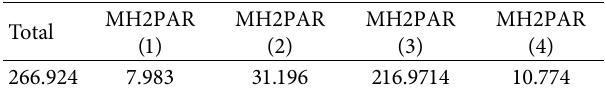
Table 21: Total mass of recombined hydrogen (kg H